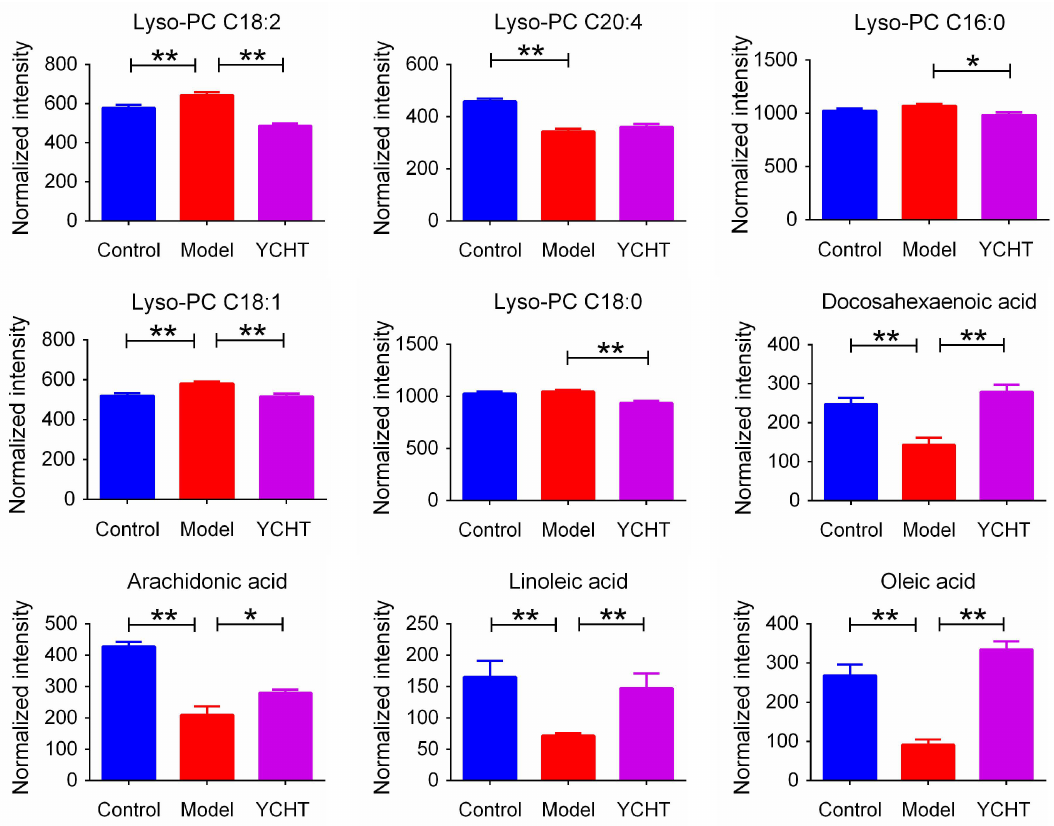
Figure 5. Altered levels of candidate markers in the control, model and YCHT treated rats. Data are represented as mean ˘ SEM ( n = 15 in each group), with * p < 0.05 and ** p < 0.01 from one-way ANOVA analysis. Lyso-PC C16:0 and Lyso-PC C18:0 could not be considered as fibrosis-related